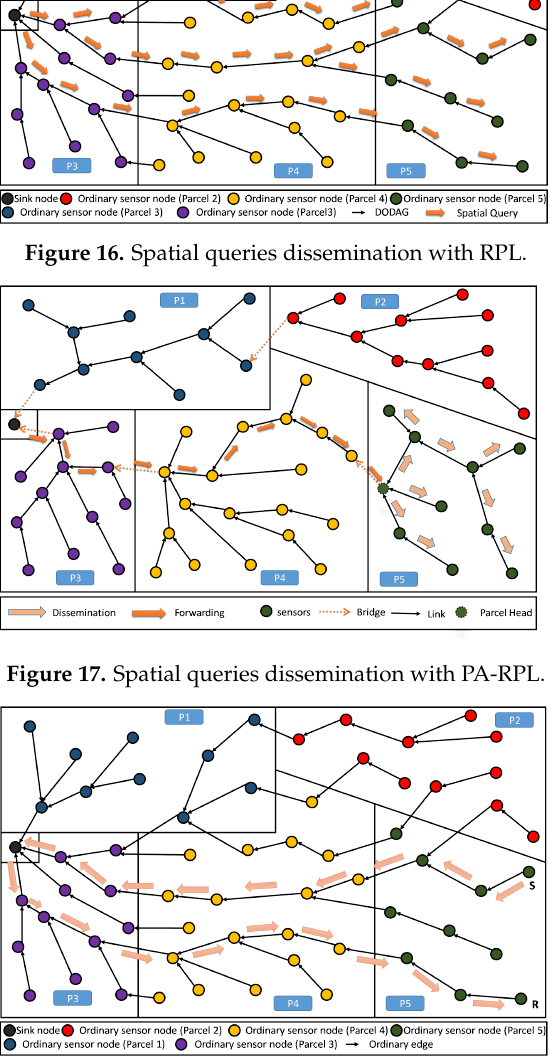
Figure 18. Intra-parcel message exchange with